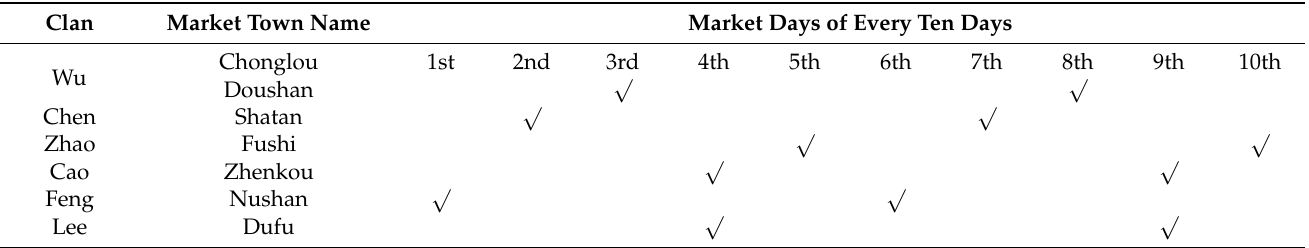
Table 6. Summary of the market days of market towns in the region between the Doushan River and the Zhenkou River.